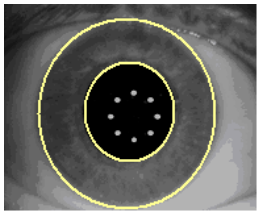
Figure 6. Visible iris pattern definition.